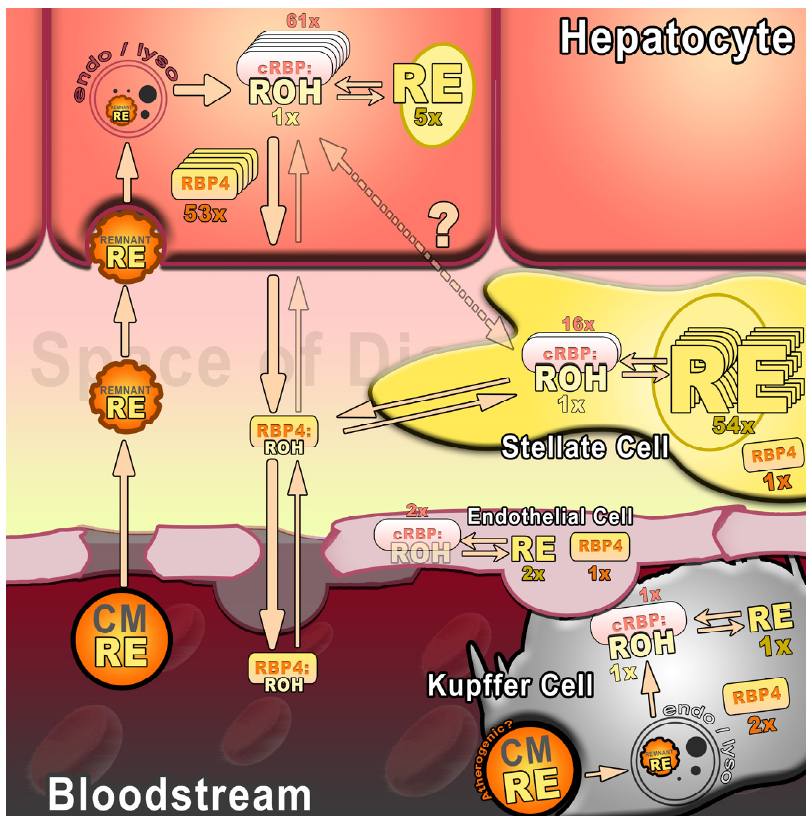
Figure 1. Schematic representation of hepatic vitamin A turnover. Circulating retinyl esters (REs) contained in chylomicron (CM) remnants and retinol:retinol-binding protein 4 complexes (ROH:RBP4) pass endothelial fenestrations and enter the space of Disse. CM remnants are taken up via endocytosis and cleared in endosomes/lysosomes (endo/lyso) by various cell types. Intracellularly, ROH, bound to cellular retinol-binding protein (cRBP:ROH), is esterified to RE or secreted as ROH:RBP4 complexes. Arrows indicate metabolic fluxes and are adapted from [55,56]. Relative amounts of retinoids (ROH + RE) and retinol-binding proteins (cRBP and RBP4) are indicated by fold difference (x = fold) between cell types (on a per cell basis as determined in [57]). To improve clarity, differences larger than 10 × are additionally indicated by reduplicated symbols in increments of ten. Note: The relative amount of liver cells (hepatocytes, stellate, Kupffer, and endothelial cells, comprising roughly 78%, 1.4%, 2.8%, and 2.1% of liver volume, respectively [16]), is not reflected in the figure.